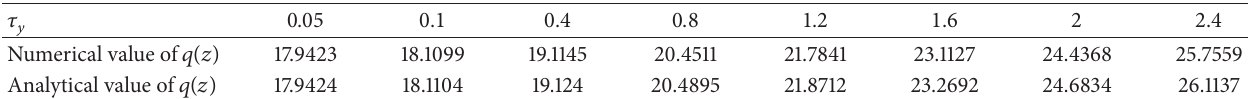
Table 1: A comparison between numerical value of pressure gradient and approximate value of pressure gradient at the midpoint of stenotic region for different values of yield stress taking 𝑛 = 0.8, 𝑘 = 1.2, 𝜁 = 0.01 , and 𝛿 1 = 0.2 . 𝜏 0.05 𝑦